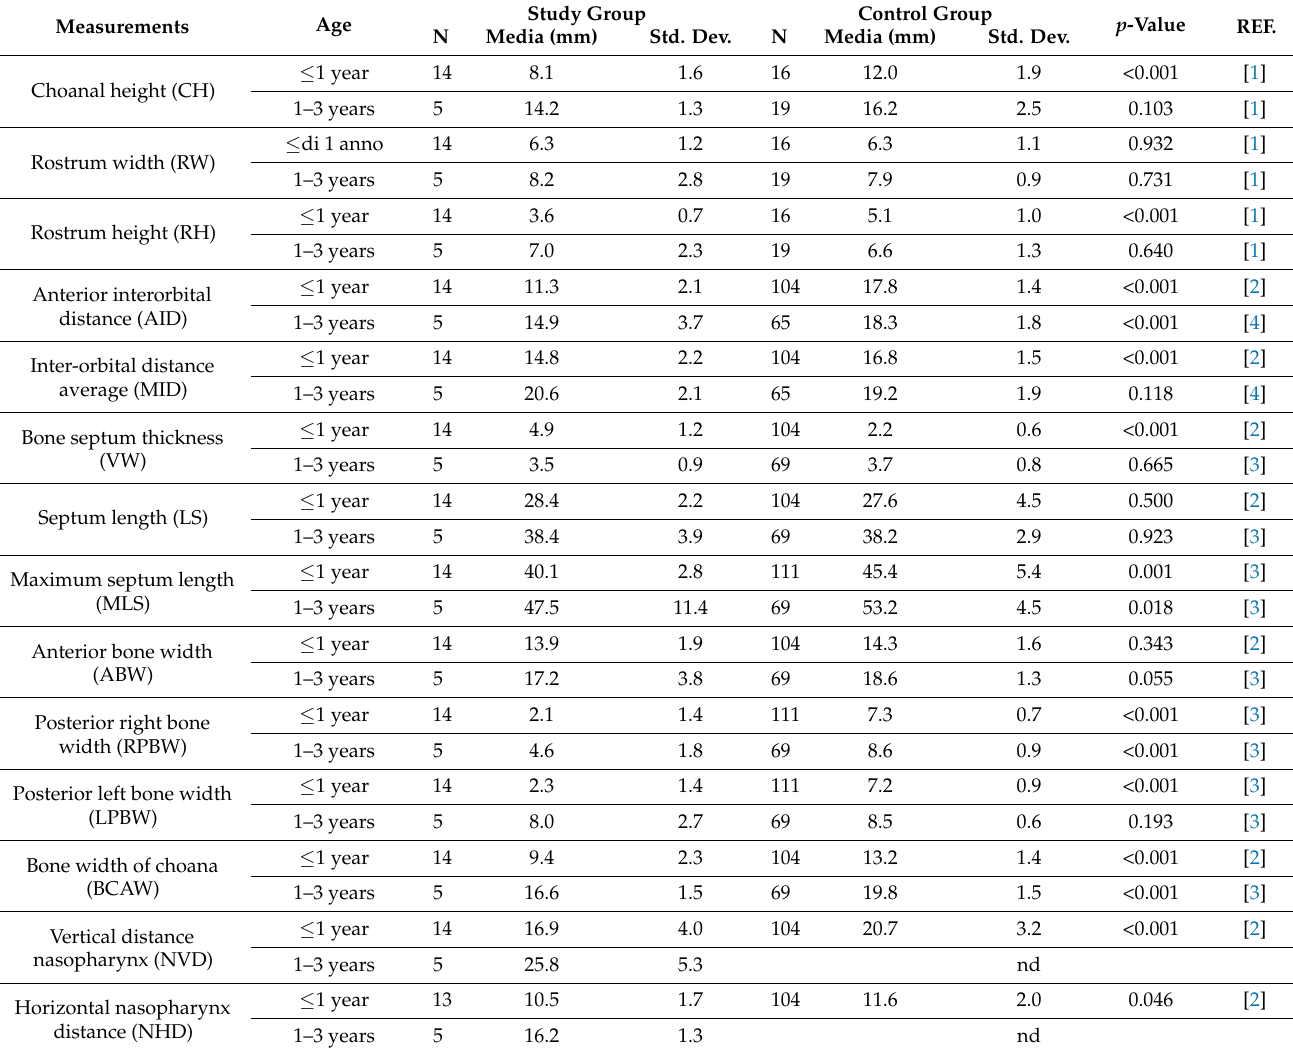
Table 2. Comparison of averages of patients with choanal atresia and control